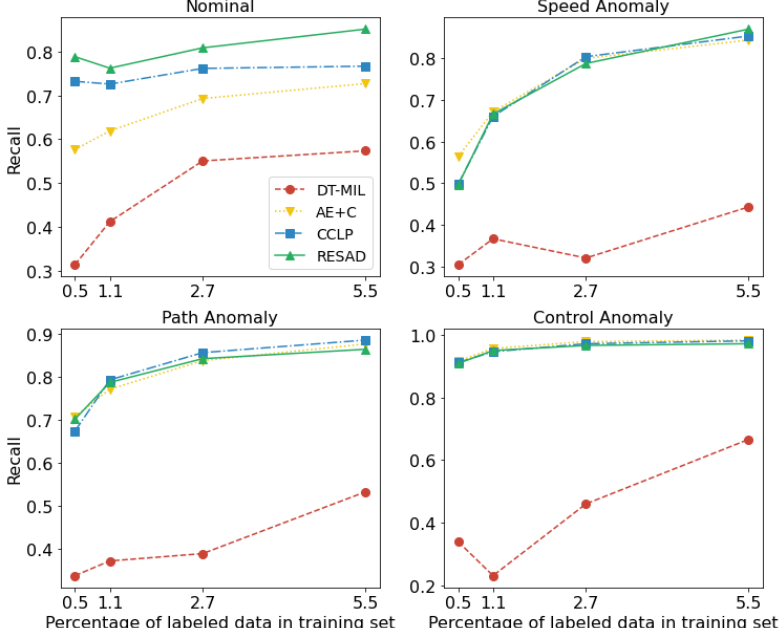
Figure A6. This figure compares performance (recall per class) of our proposed model (colored green) with multiple baseline methods, such as DT-MIL (red), AE+C (yellow), and CCLP (blue).